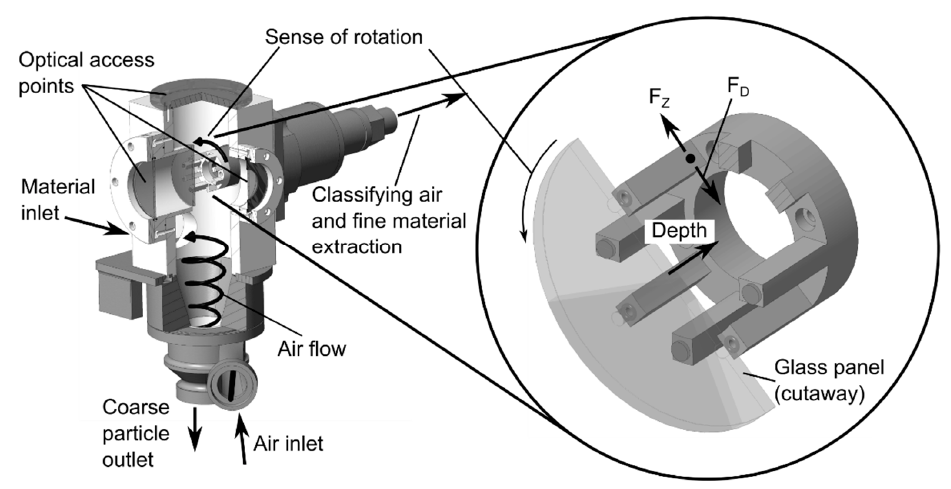
Figure 3. Deflector wheel classifier, basic principle, and modifications for optical access.